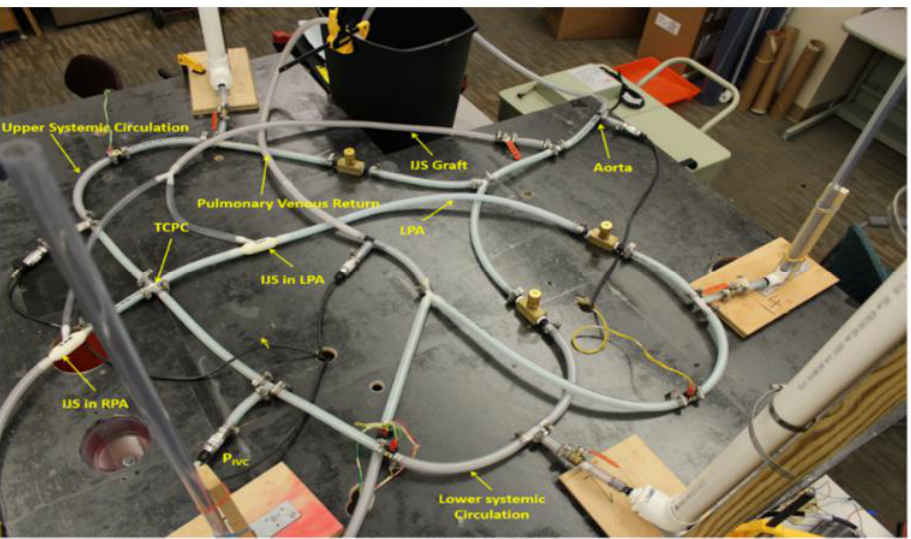
Figure 9. Mock Flow Loop set up with DAQ and compliance chambers.